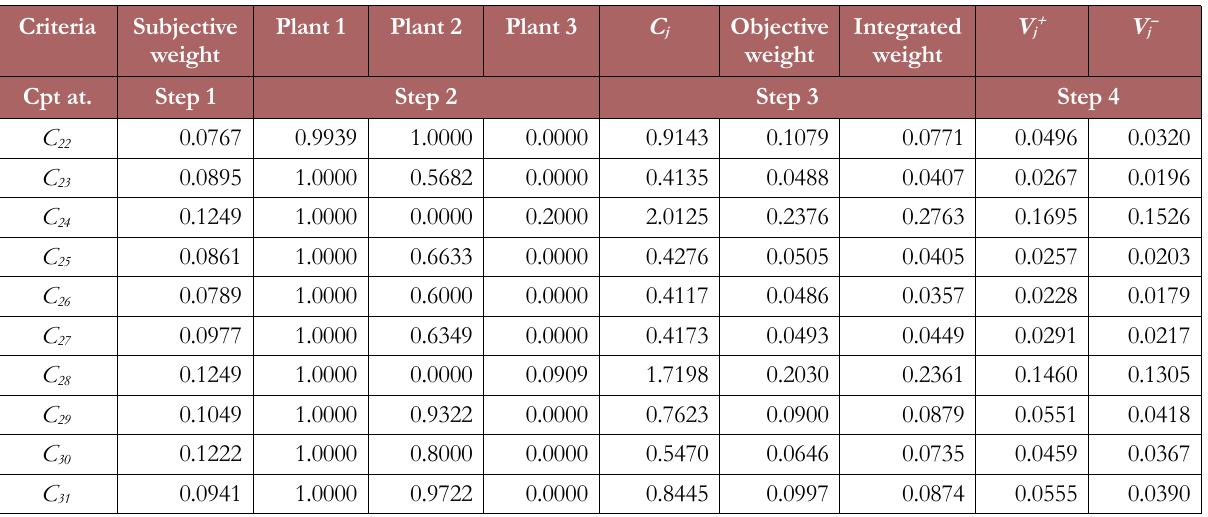
Table 7. Computation of rough BWM-CRITIC-TOPSIS (AR)